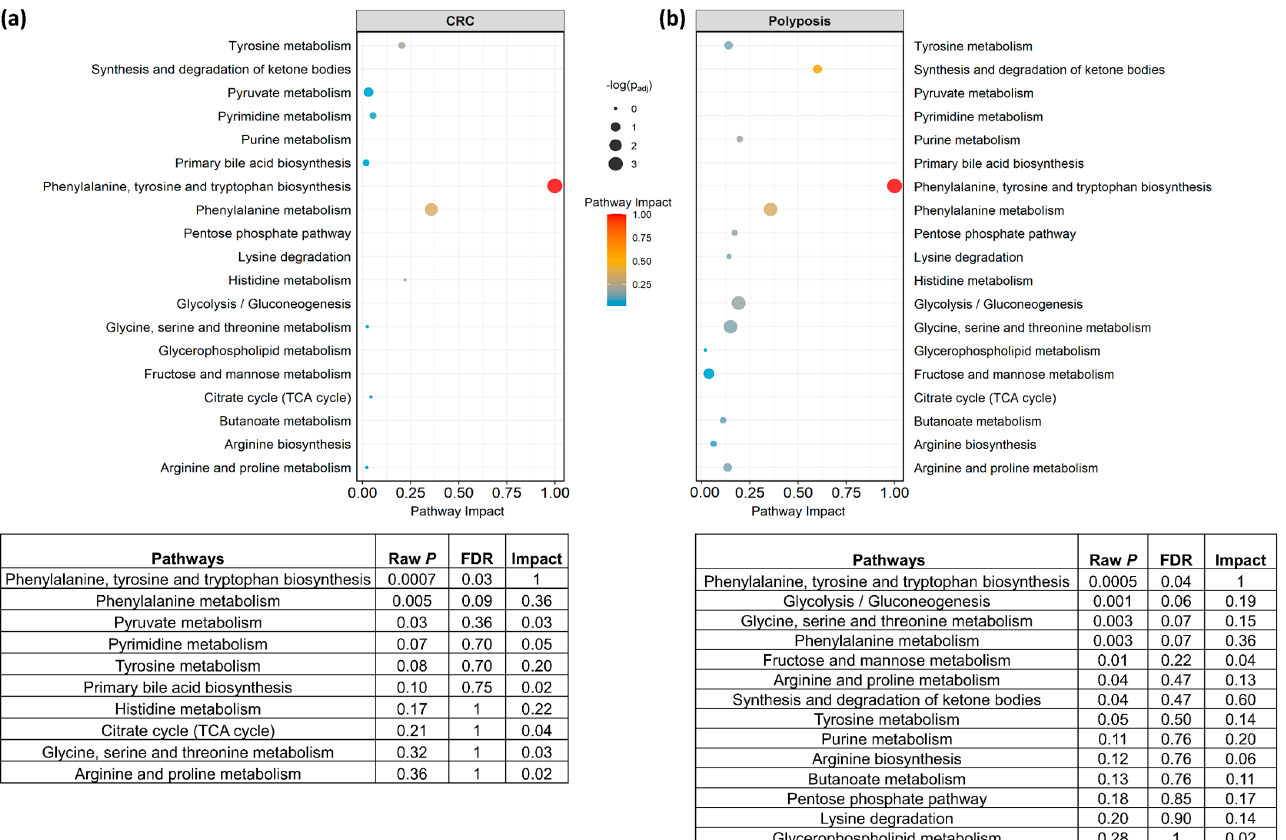
Figure 5. Pathway analysis plot according to the metabolites presenting significantly (Benjamini- Hochberg adjusted p -value ≤ 0.05) different connections in ( a ) CRC compared with CTR, and ( b ) PP compared with CTR. Dots are colored according to the metabolic pathway impact score and their dimensions are proportional to their significance. Only enriched pathways with an impact score per cohort > 0.01 were considered. For each pathway, raw p -value, FDR adjusted p -value, and the impact score are also reported.